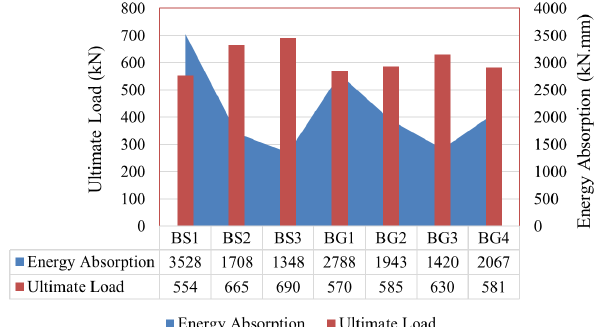
Figure 7: Energy absorption and ultimate load of tested